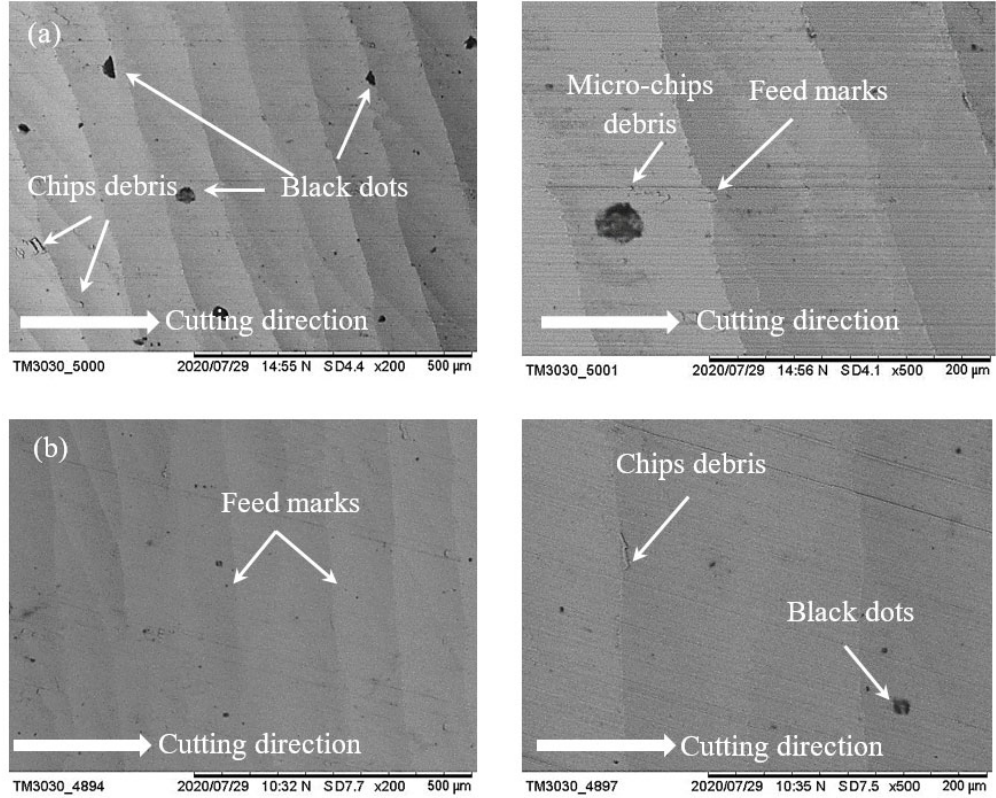
Figure 13. SEM photographs of machined surface at predicted parametric combinations with ( a ) conventional cutting fluid, n = 16,000 rpm, f = 400 mm/min and P = 800 mW, ( b ) water ‐ soluble sago starch cutting fluid, n = 16,000 rpm, f = 400 mm/min and P = 727 mW.